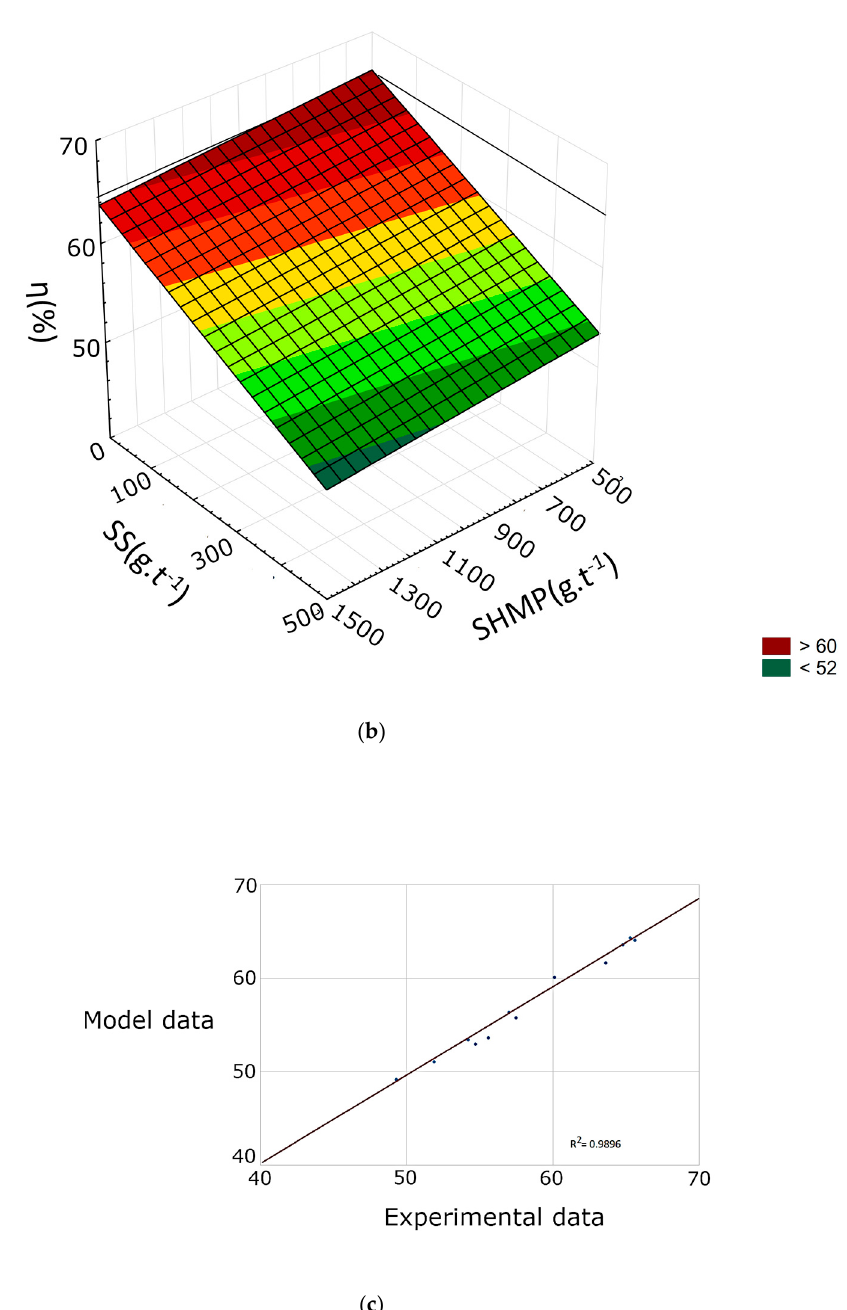
Figure 4. ( a ) (50 g.t − 1 MIBC), ( b ) (80 g.t − 1 MIBC), ( c ): Response surfaces representing the effect of SHMP and SS on separation efficiency at different dosages of MIBC frother. The thick black lines represent the recovery of talc achieved using frother as the only reagent.